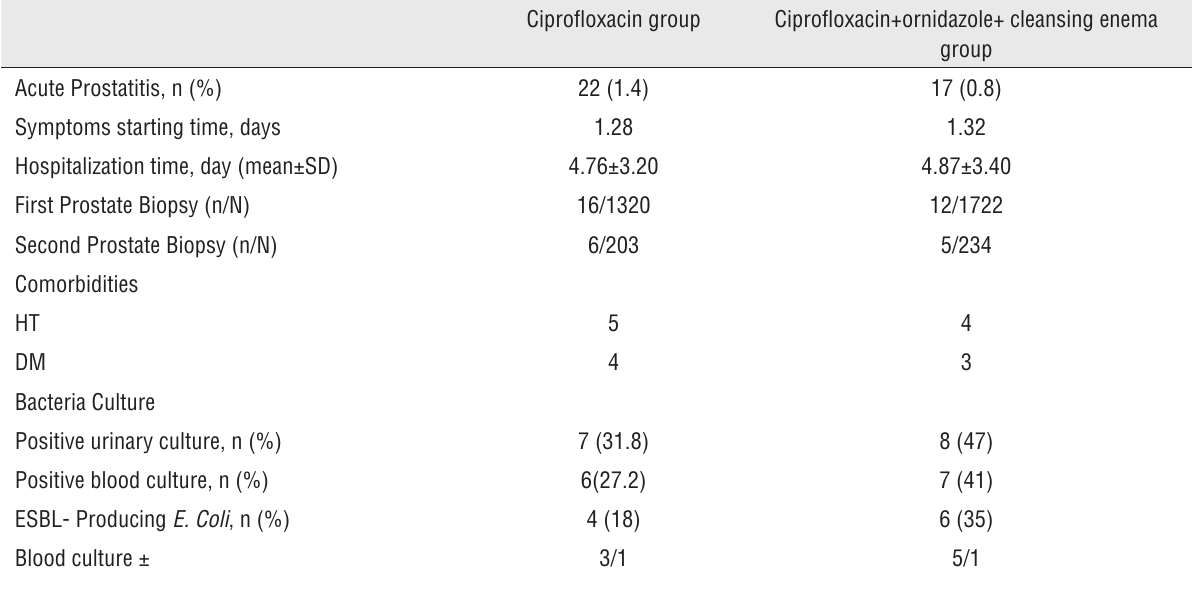
Table 2 - Analysis of acute prostatitis cases in different prophylactic treatment regimes of transrectal postate biopsy. ESBL- Producing E. Coli: Extended-spectrum Beta-lactamase and Quinolone-resistant Escherichia Coli